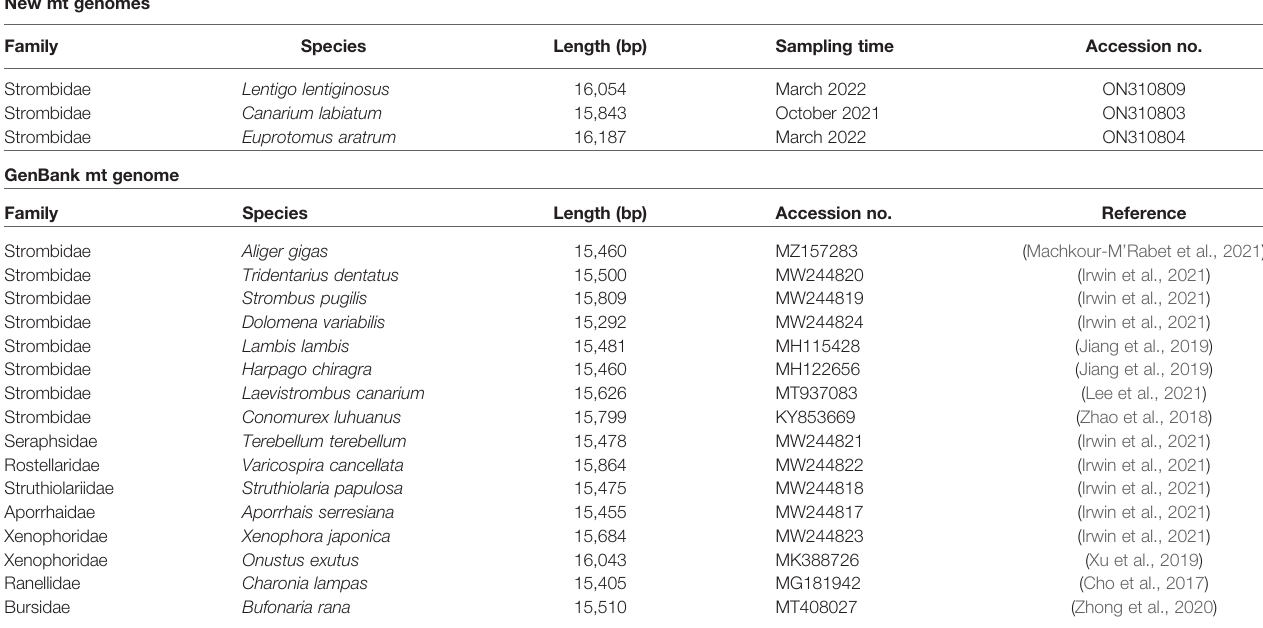
TABLE 1 | List of mt genomes used in the present